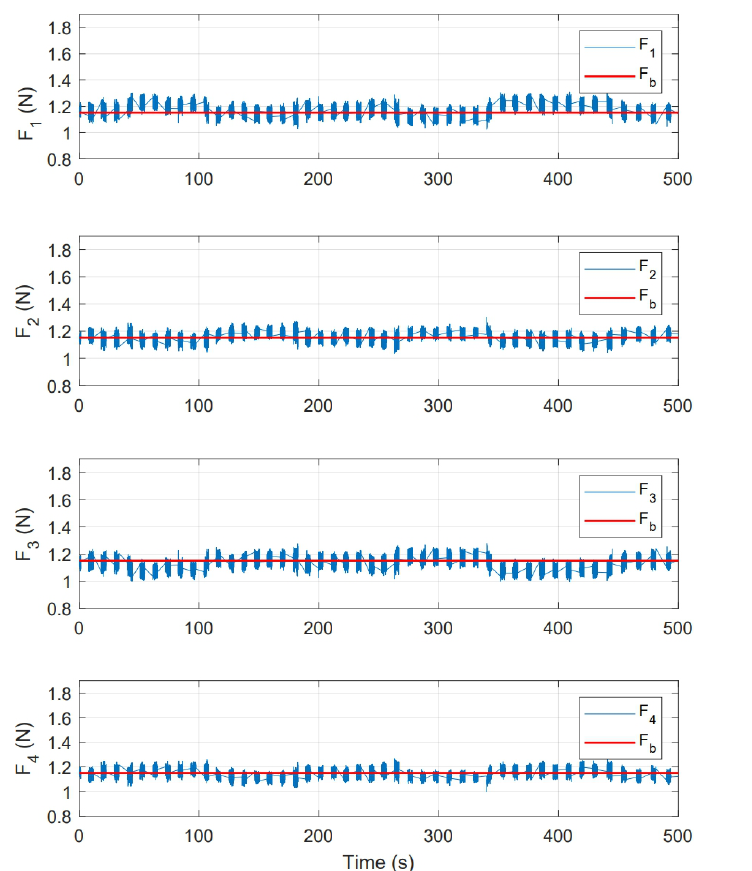
Figure 19. Thrust force presented for each motor in state feedback